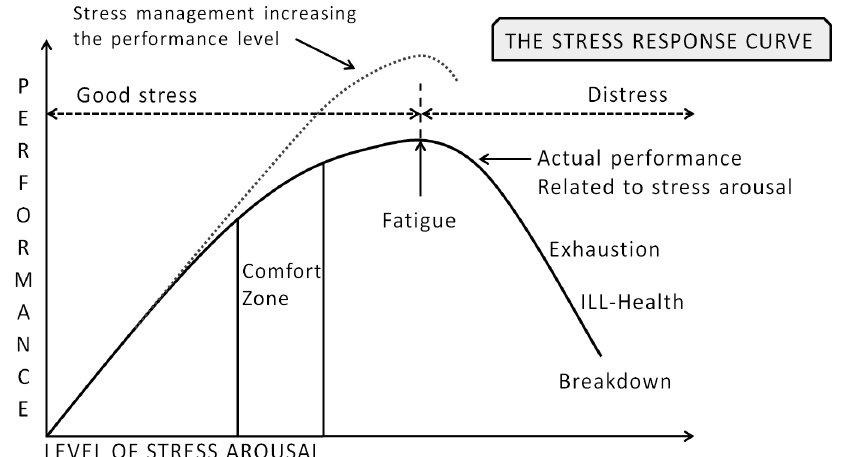
Fig. 5. Relationship between the level of stress and performance depicted in the form of an inverted U-curve. Based on the work of Nixon (1979), illustrating the effect of stress management methods on